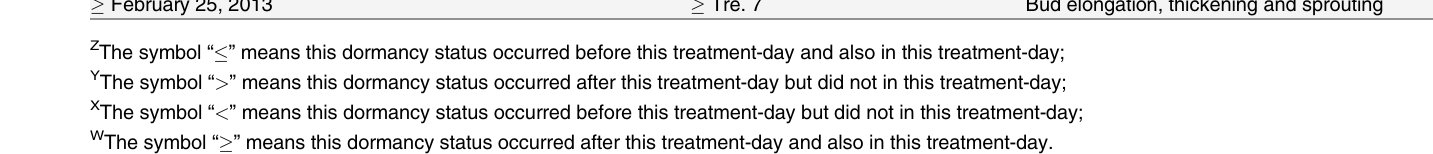
transcriptome level. As shown by Table 10 and S2 Table, we could obtain the profile of physio- logical or biochemical metablisms during the five adjacent dormant phases based on KEGG pathway annotation. The first half of Table 10 showed the summary of DEGs annotated by KEGG pathway. The percentage of NDK/ND is not high, only 3 to 18%. The number of up-regulated DKs is more than the down-regulated ones in most phases. In the latter part of this table, we can find that main metabolic pathways were glutathione metabolism, metabolism of xenobiotics by cyto- chrome P450, starch and sucrose metabolism, etc. in the phase of Tre. 1-VS-Tre. 2 (means the